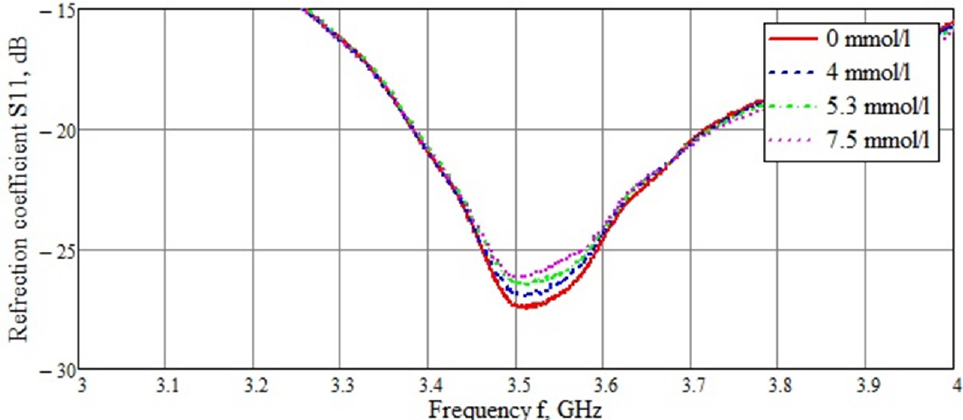
Figure 17. Frequency dependence of the reflected signal from the bidirectional probe for various glucose concentrations. Frequency range 3–4 GHz. The amplitude changes for each concentration are shown in Table